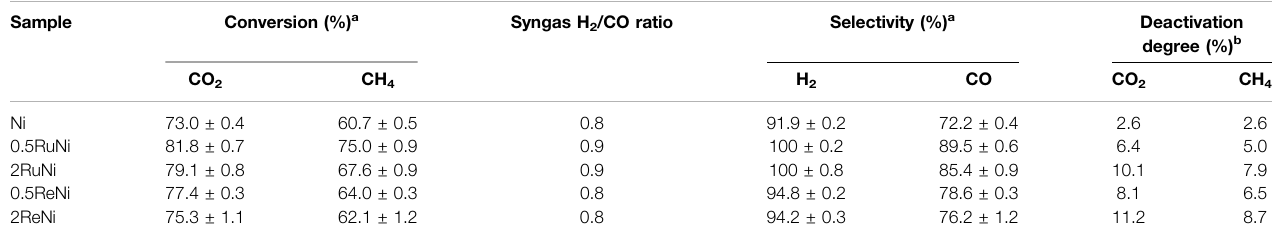
TABLE 4 | Catalytic performance of the synthesized samples.